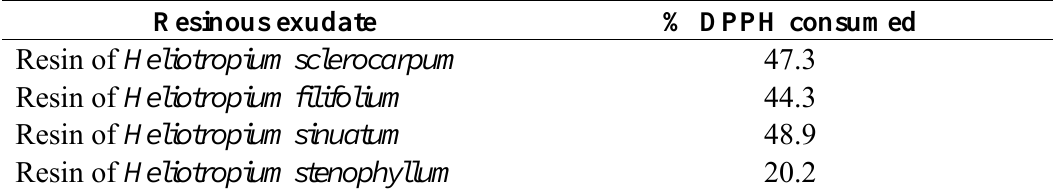
Table 2. Comparison of the percentage of DPPH radical consumed by the resin obtained of H. sclerocarpum , H. filifolium , H.sinuatum and H.